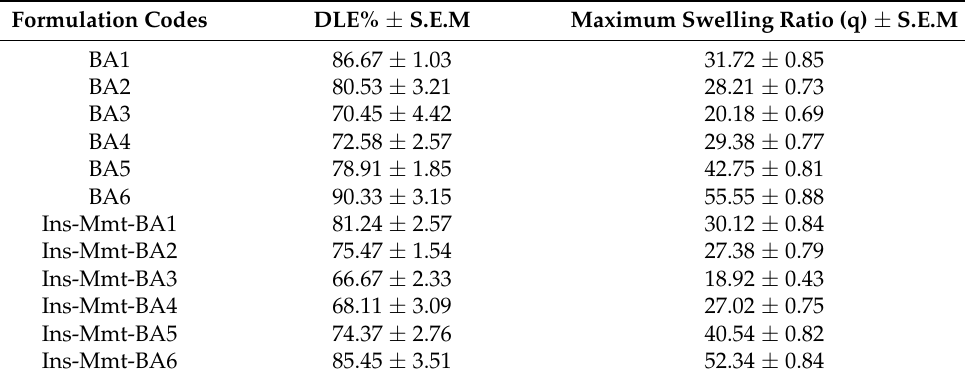
Table 2. Results of DLE (%) and maximum swelling ratio (q) for all developed formulations. Formulation